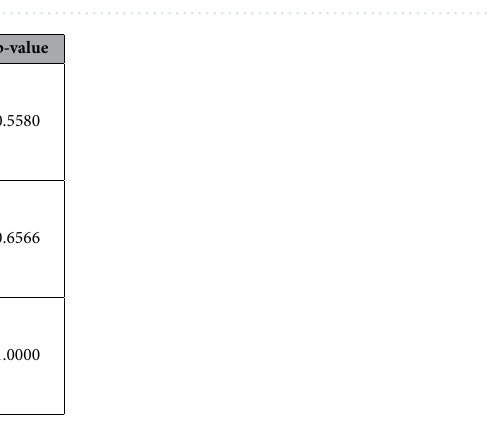
Figure 3. Laser Doppler imaging of male mice models of hindlimb ischemia. ( A ) Blood flow measurements of ischemic left hindlimbs in male vehicle (control)-treated mice subjected to 90 min ischemia the hindlimb baseline (pre-ischemia) flux, as well as the reperfusion flux, were significantly ****P = 0.0001 higher than ischemic flux. ( B ) Representative Laser Doppler images in control mice during baseline, ischemia, and reperfusion. ( C ) Blood flow measurements of ischemic left hindlimbs in male mice treated with NIM-811 subjected to 90 min ischemia the hindlimb baseline (pre-ischemia) flux, as well as the reperfusion flux, was significantly ****P = 0.0001 higher than ischemic flux. Moreover, the reperfusion flux was significant **P = 0.0006 vs. baseline (pre-ischemia). ( D ) Representative Laser Doppler images in male mice treated with NIM-811 during baseline, ischemia, and reperfusion.